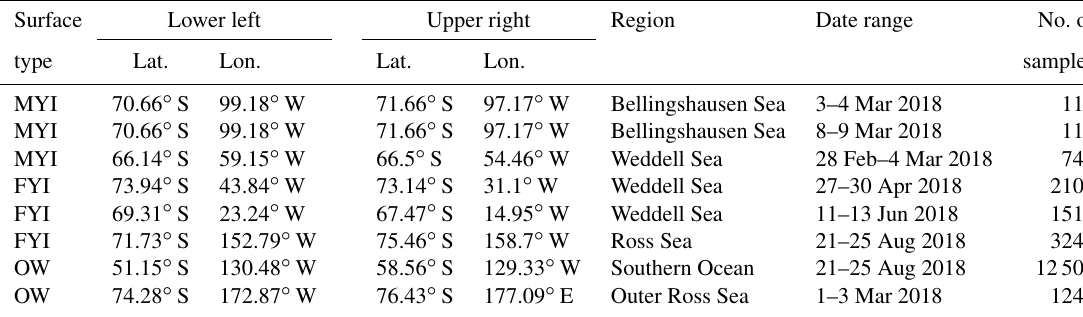
Table A2. Sampling areas for MYI, FYI, and open water (OW). Note: Lat. = Latitude, Lon. = Longitude, No. = number. Surface Lower left Upper right Region Date range No. of type Lat. Lon. Lat. Lon. samples MYI